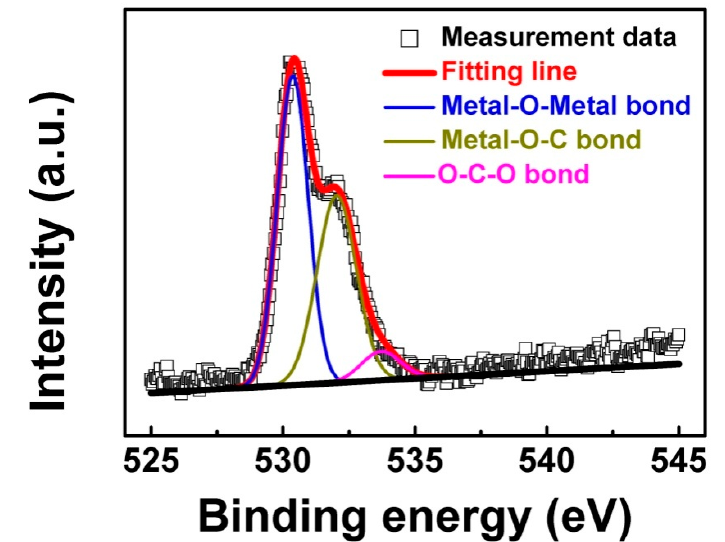
Figure 6. Gaussian peak fitting procedure applied to O 1 s high-resolution XPS spectrum of ITO film (i) bombarded by a CH + x beam, after 4 min of Ar + cleaning.